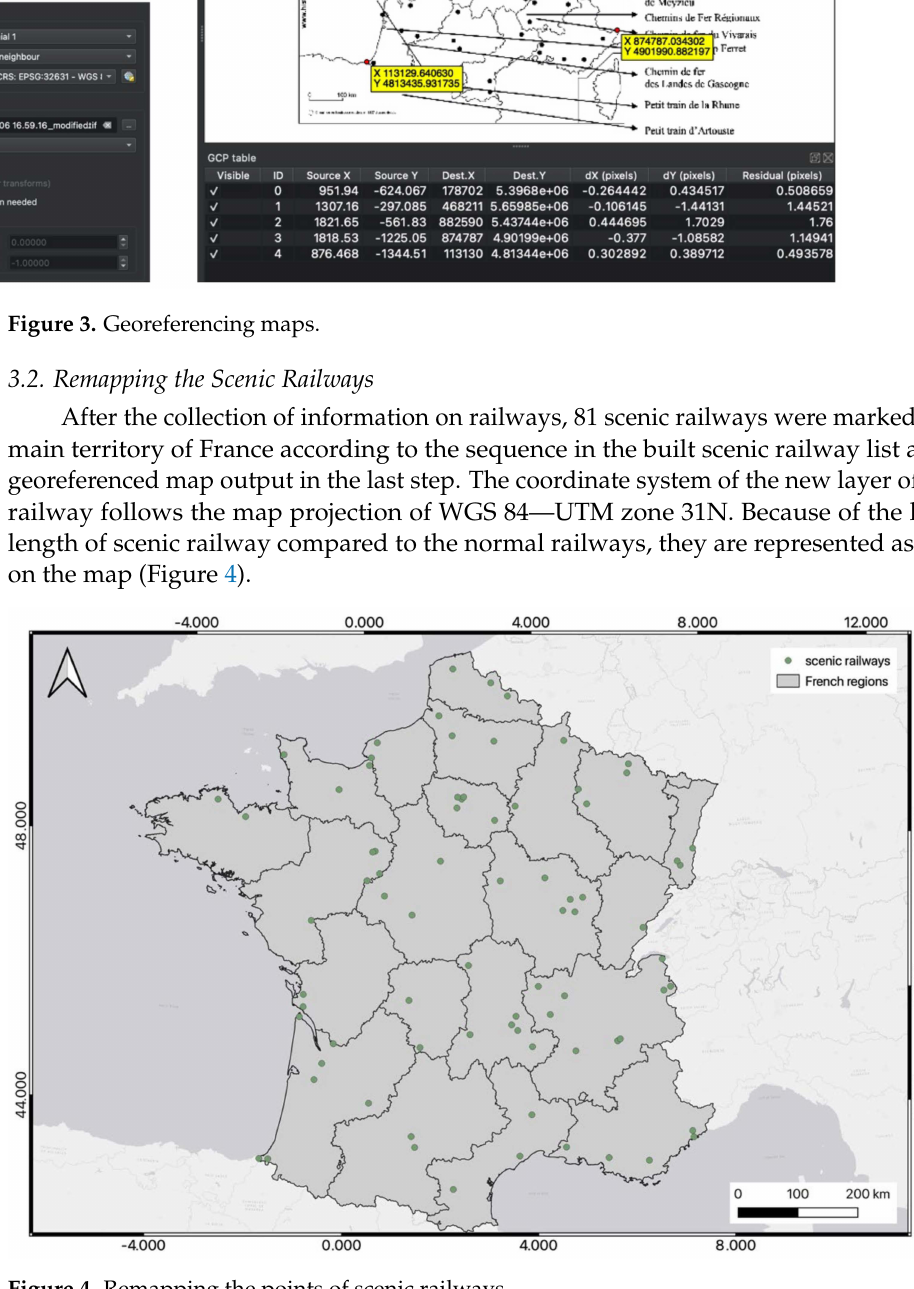
Figure 4. Remapping the points of scenic